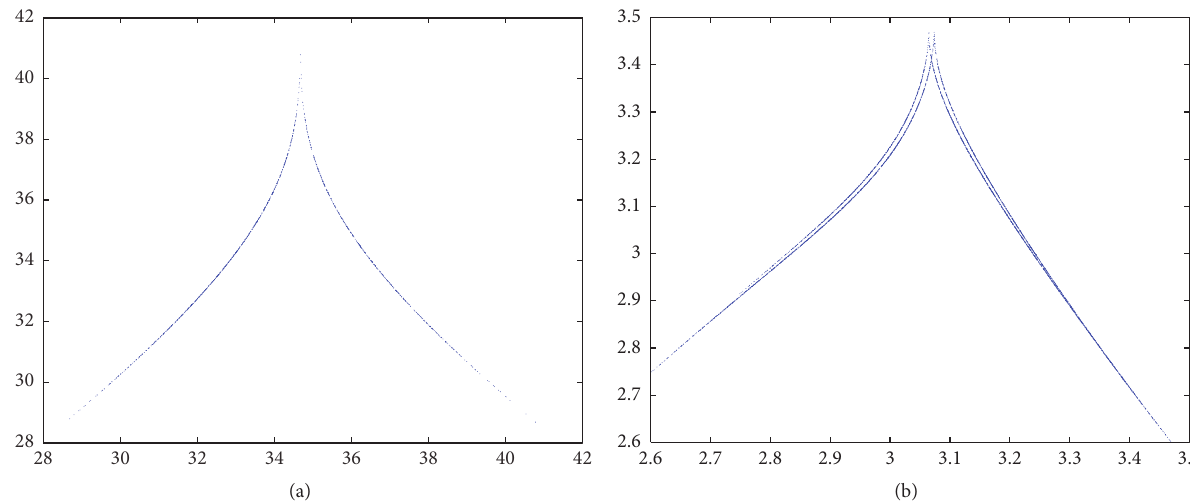
Figure 2: First return map for (a) Lorenz system {𝜎 = 10 , 𝜌 = 178 , and 𝛽 = 8/3} and (b) proposed system {𝑎 = 20 , 𝑏 = 2 , 𝑐 = 3 , and 𝑑 = 10}